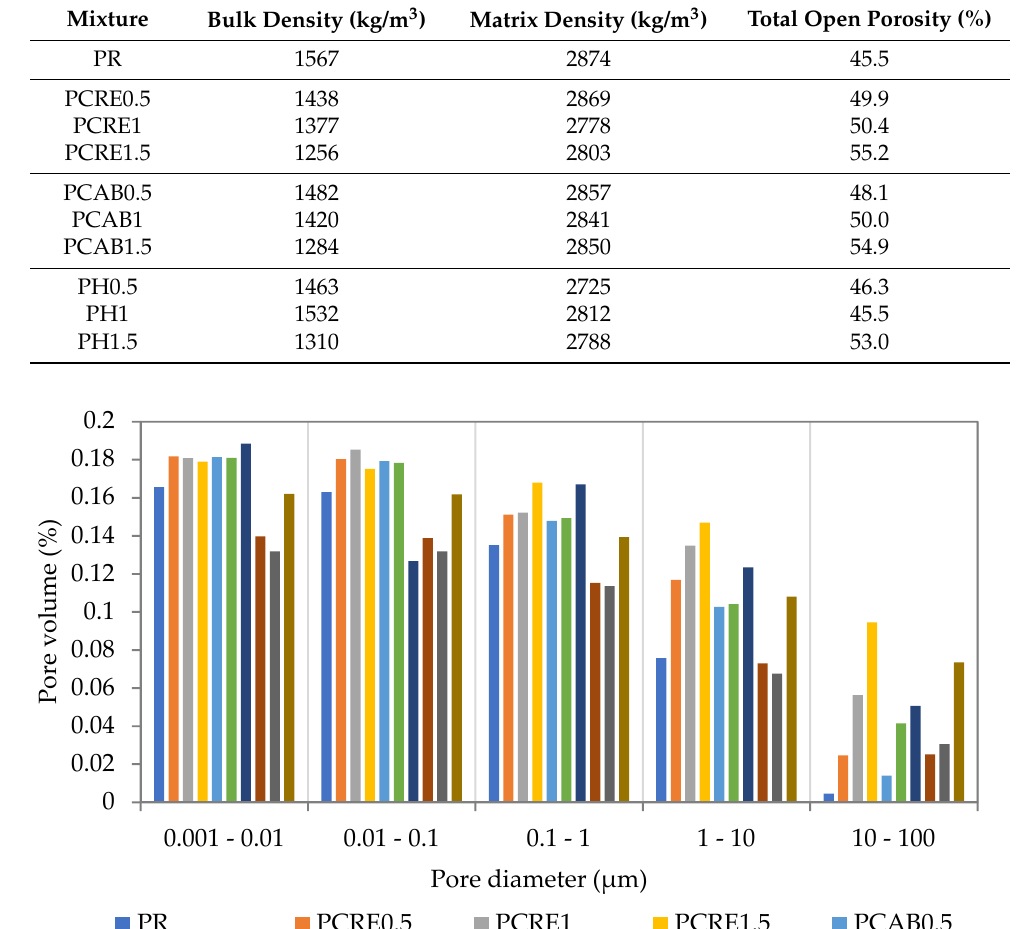
Table 3. Basic material properties of studied plaster mixtures.